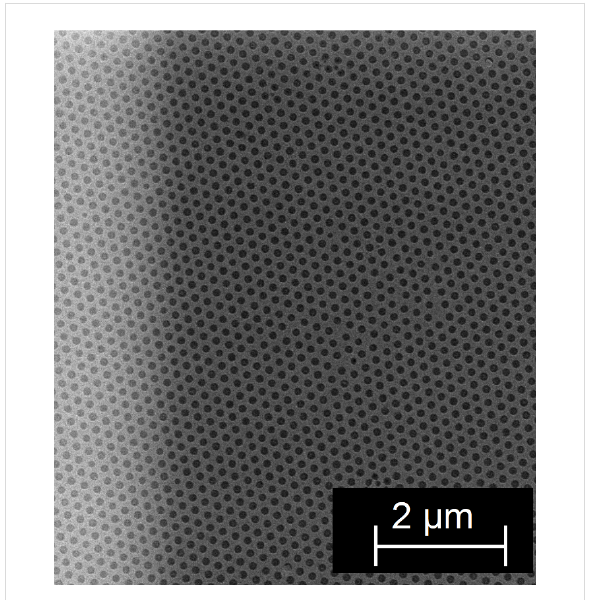
Figure 2: SEM image of Fe antidot array with a period a = 200 nm, an antidot diameter d = 125 nm and a thickness t = 20 nm. The bright contrast on the left arises from the supporting Si frame of a 500 nm thick Si 3 N 4 membrane window (dark contrast) for transmission imaging. Remarkably, such windows survive the mechanical polishing